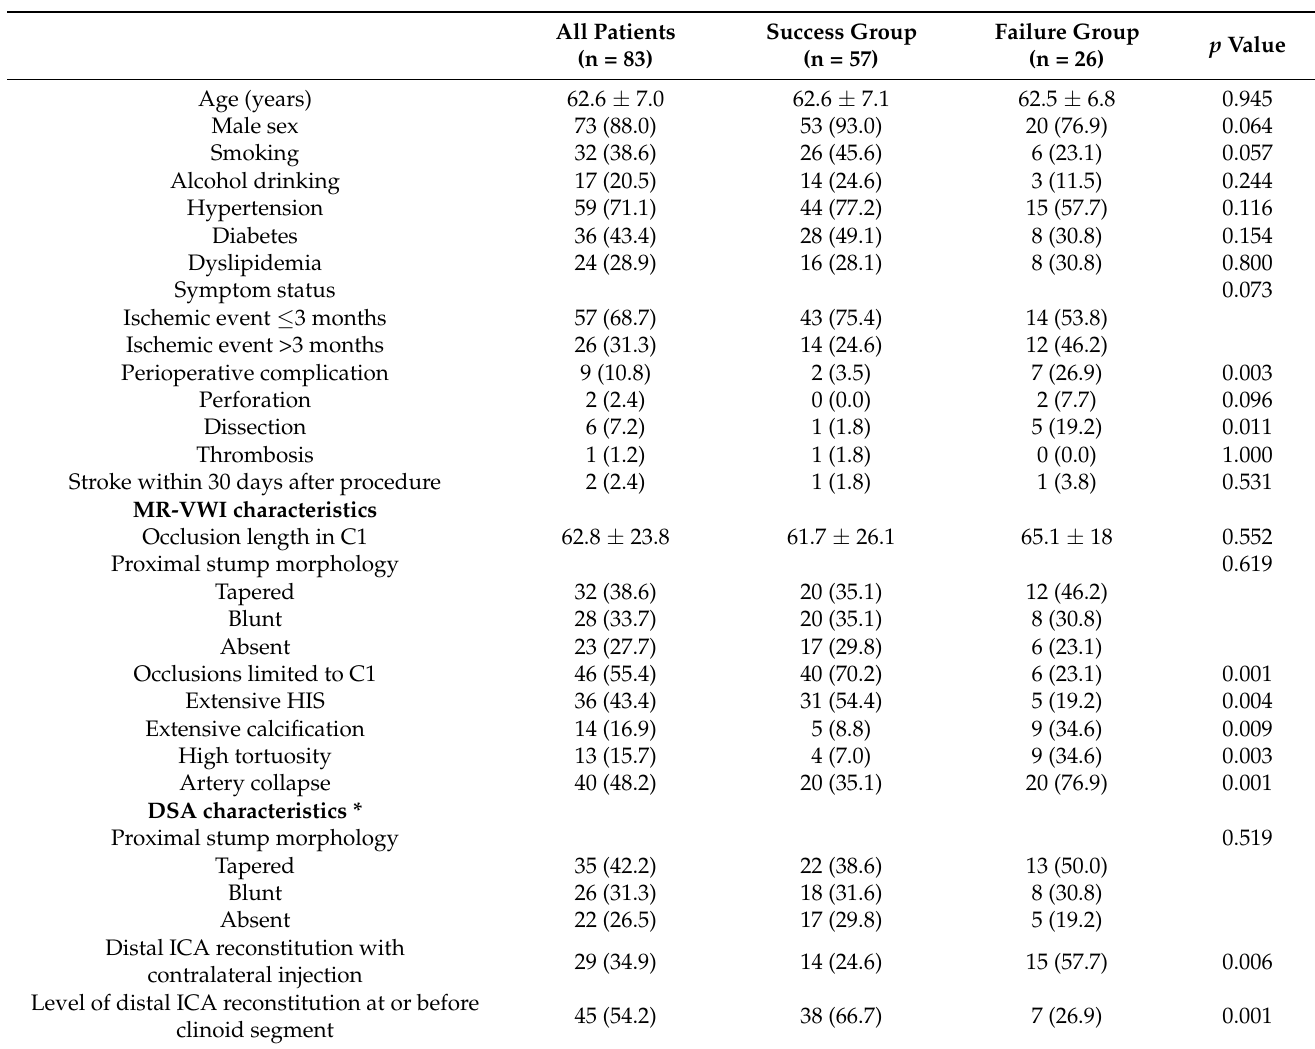
Table 1. Clinical and imaging